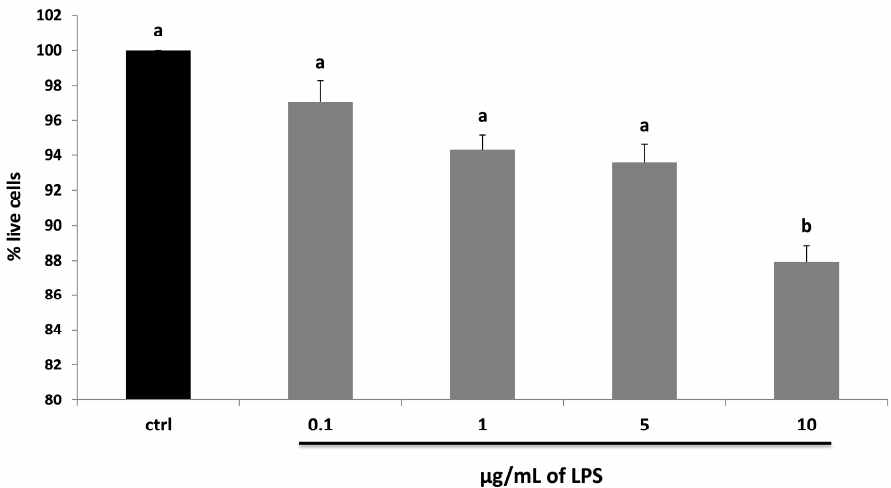
Figure 2. MTT assay for the determination of cell viability in HDF cells treated with different concentrations of LPS (0.1–10 µg/mL) for 24 h (grey bars). Black bar represents the control group. Data are expressed as mean values ± SD. Values with different superscript letters are significantly different ( p < 0.05).